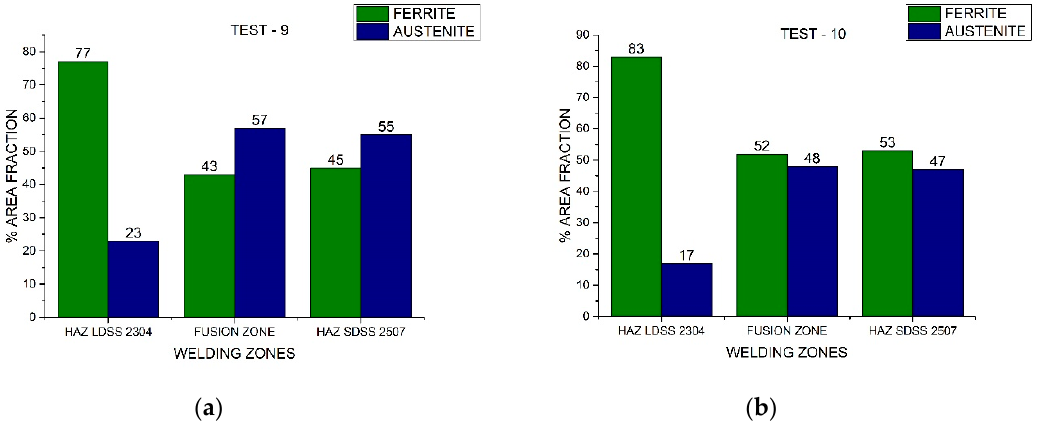
Figure 12. Area fraction through the distinct welded zones to 130 A: ( a ) Test #9 and ( b ) Test #10.